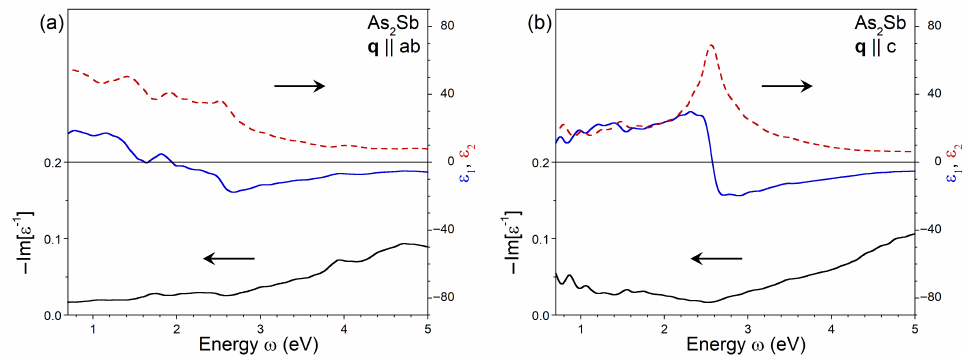
Figure 4. Imaginary (red dashed line) and real (blue solid line) parts of dielectric function in As 0.67 Sb 0.33 calculated at q pointing in ( a ) ab plane and ( b ) c direction obtained with inclusion of the local-field effects and the ALDA kernel. The respective loss function, − Im [ (cid:101) − 1 ] , is shown by black solid